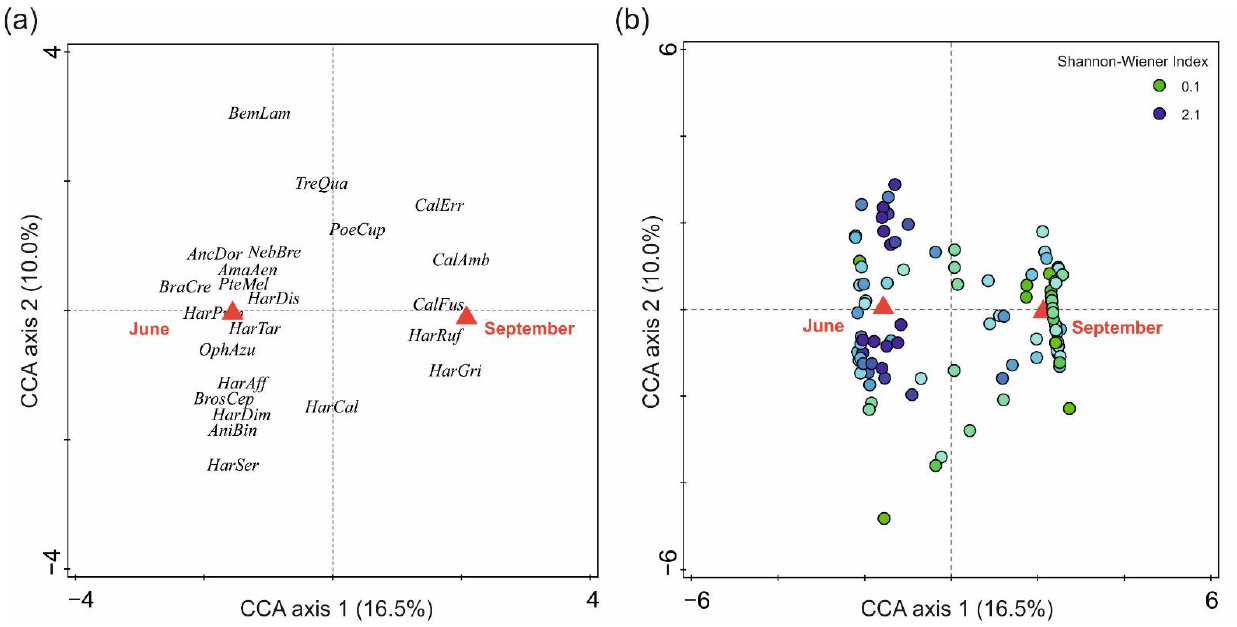
Figure 2. Canonical correspondence analysis (CCA) ordination of ground beetle communities col- lected at two sampling times (June, September 2016). ( a ) CCA species (abbreviated by the genus and species names) separated according to the sampling timepoint. ( b ) Shannon–Wiener-Index calculated from the samples obtained in June ( n = 54) and September ( n = 54) across the nine vineyard sites and three inter-row management treatments in each vineyard.